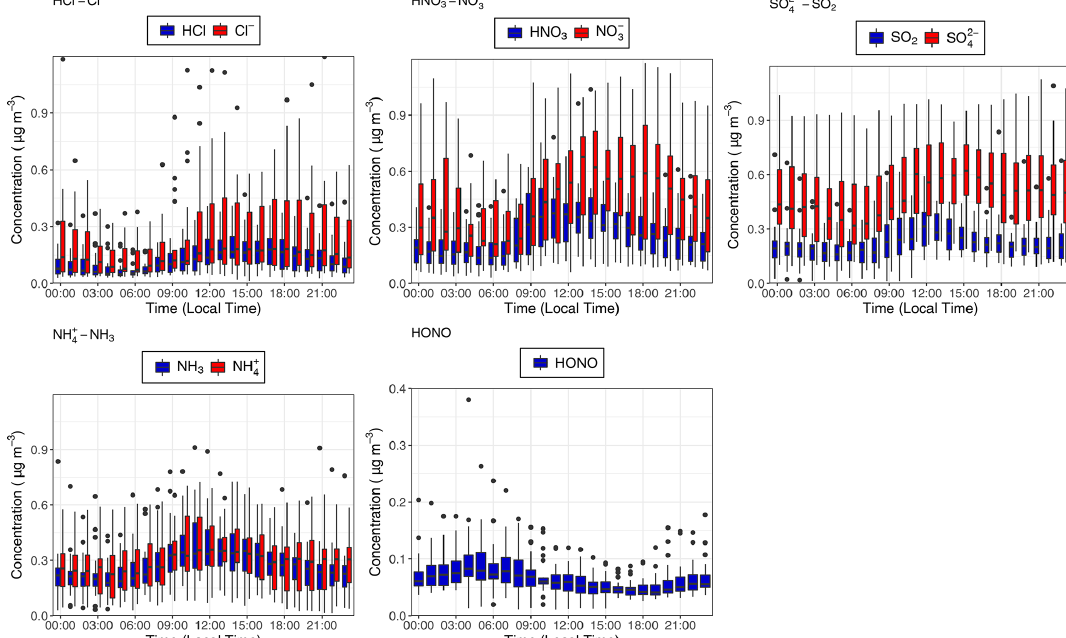
Figure 4. Median hourly diel concentrations for the inorganic trace gases NH 3 , SO 2 , HONO, HNO 3 and HCl in blue, as well as their paired associated aerosol counterparts NH + , SO 2 − , NO − and Cl − in red at the 60m sampling height measured during the campaign. The lower and 4 4 3 upper edges of each box correspond to the first and third quartiles, respectively, while the whiskers extend to the largest and smallest values which do not exceed 1.5 times the inter-quartile range from their respective hinge. Black dots outside the plots are values which exceed 1.5 times the inter-quartile range.